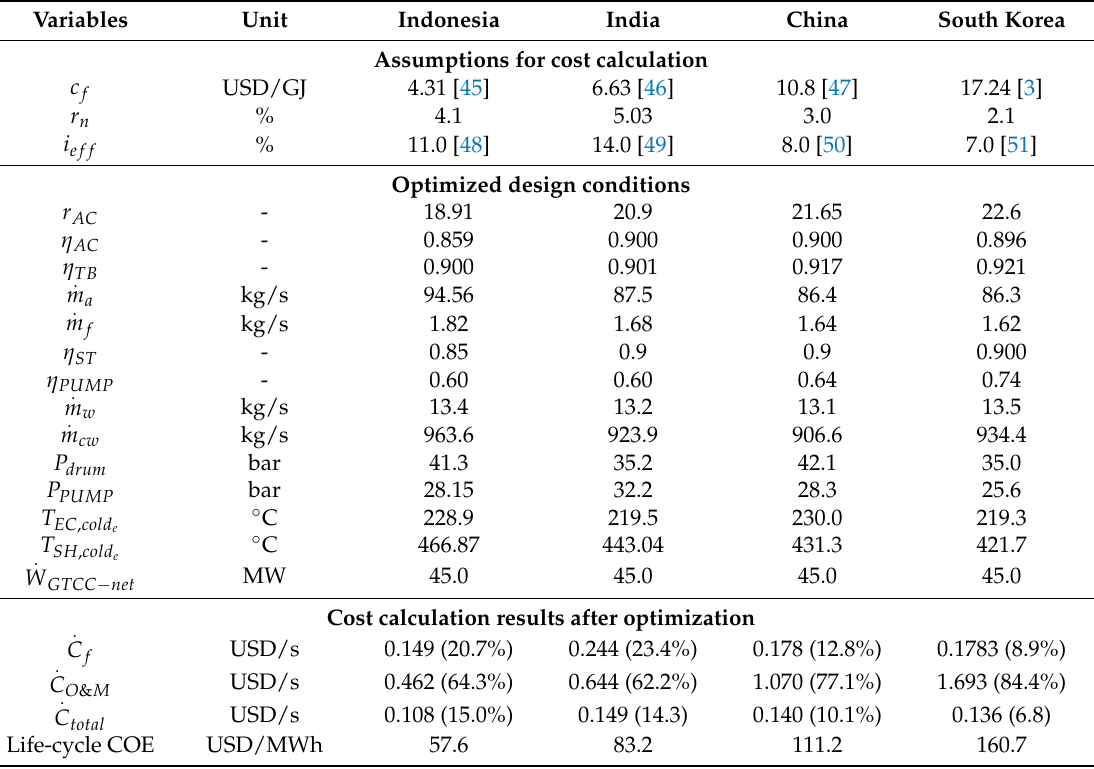
Table 12. Optimal design condition and life-cycle cost calculation for different nominal escalation rates and discount